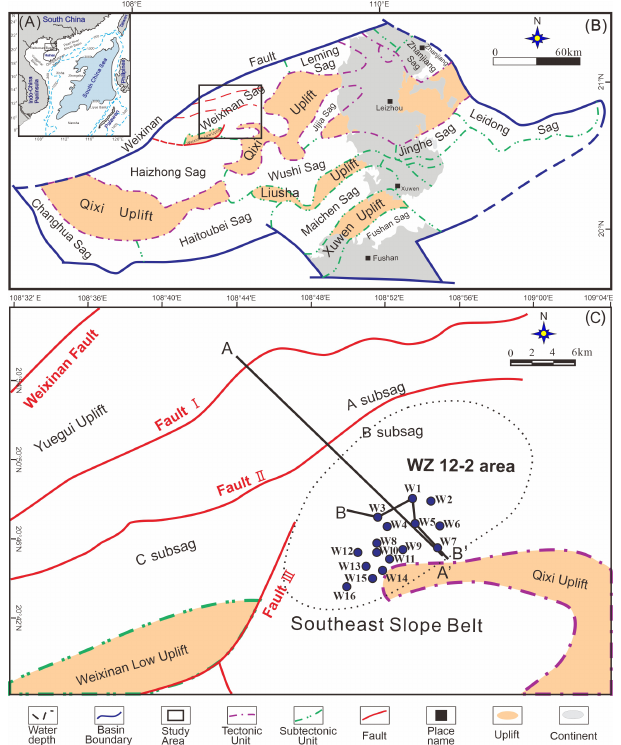
Figure 1. ( A ) Location of sedimentary basins in the South China Sea. The black box indicates the location of Figure 1B; ( B ) simplified geological map of the Beibuwan Basin [16,20]. The Weixinan sag was located in the northwestern Beibuwan Basin. The black box refer to the study area in Figure 1C; ( C ) simplified geological map of the Weixinan sag. The black line AA’ and BB’ mark the locations of seismic section and sequence stratigraphic correlation sections in Figures 3 and 9,